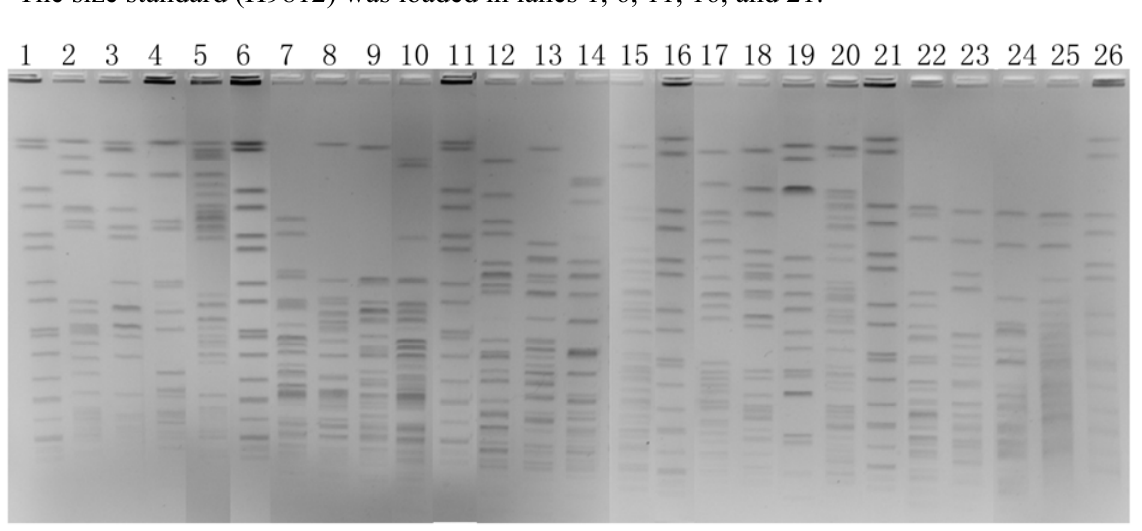
Figure 2. PFGE images of four K. pneumoniae isolates restricted with Avr II (lanes 2 to